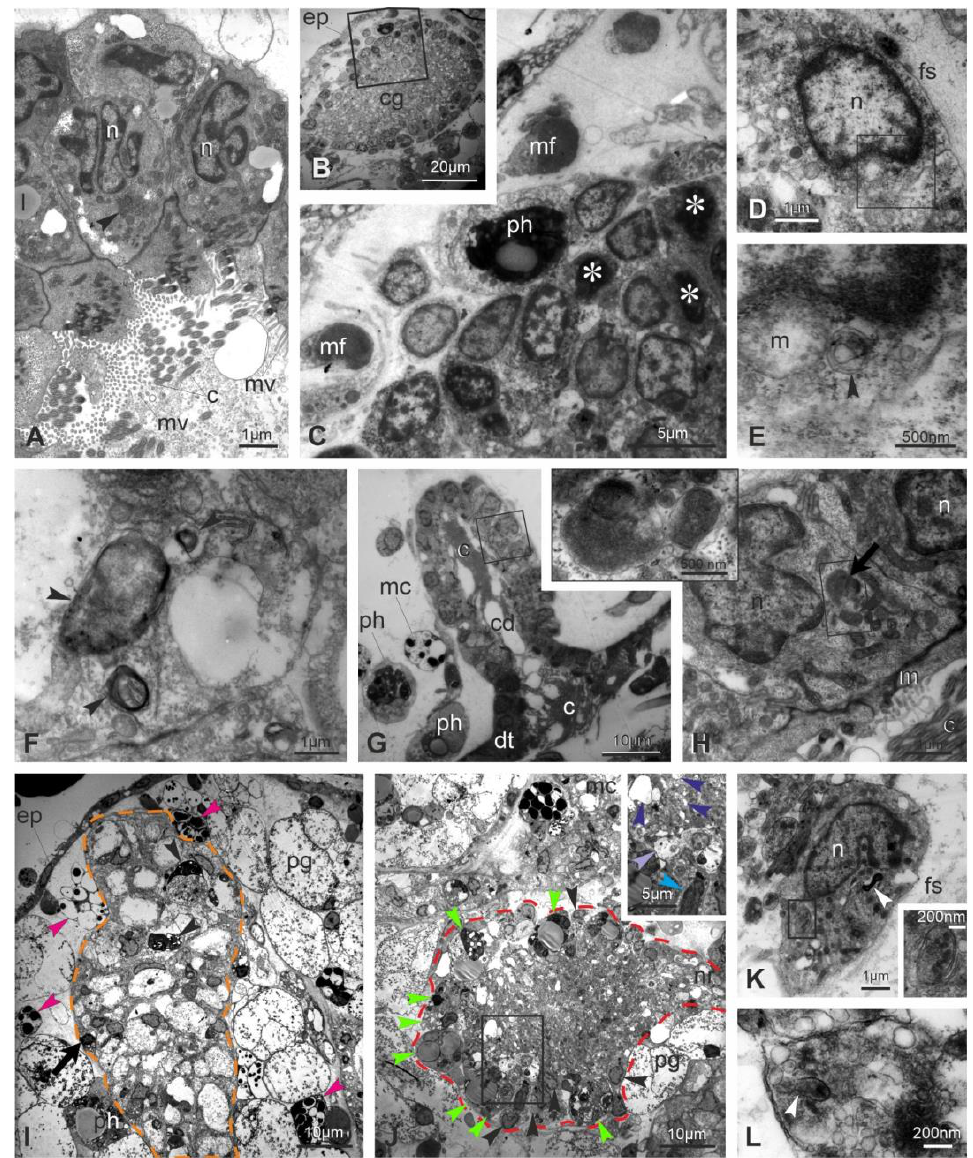
Figure 4. Ultrastructure of the neural complex in regressing zooids at sub-stages 11 2 − 3 ( A – F ) and 11 3 ( G – L ). TEM. ( A ) Ciliated duct cells show lobed nuclei (n). At their apex, both microvilli (mv) and cilia (c) project into the lumen duct. Arrowhead: glycogen granules; l: lipid droplet. ( B , C ) Cerebral ganglion (cg) displaying numerous pyknotic nuclei (asterisks). Squared area in ( B ) is enlarged in ( C ). ep: epidermis; mf: muscle fiber; ph: phagosome in a partially cut phagocyte. ( D , E ) Neuron exhibiting an autophagosome (arrowhead) close to its nucleus (n). Squared area in ( D ) is enlarged in ( E ). fs: cerebral ganglion fibrous sheet; m: mitochondrion with swollen cristae. ( F ) Autolysosomes (arrowheads) with single membrane and electron-dense degraded content are in a neural gland cell. ( G , H ) Ciliated duct (cd) degeneration: note in ( G ) the number of lobed and pyknotic nuclei and the agglutinated cilia within the duct lumen. Squared area in ( G ) is enlarged in ( H ) to show a ciliated duct cell exhibiting an autophagosome (arrowhead) close to an autolysosome with single membrane and electron-dense degraded content (arrow). Both of the autophagic figures are enlarged in inset; note the autophagosome double membrane. c: cilia; dt: dorsal tubercle; m: mitochondria; mc: morula cell; nu: nucleus; ph: phagocyte. ( I ) Degenerating neural gland (orange dotted line) with